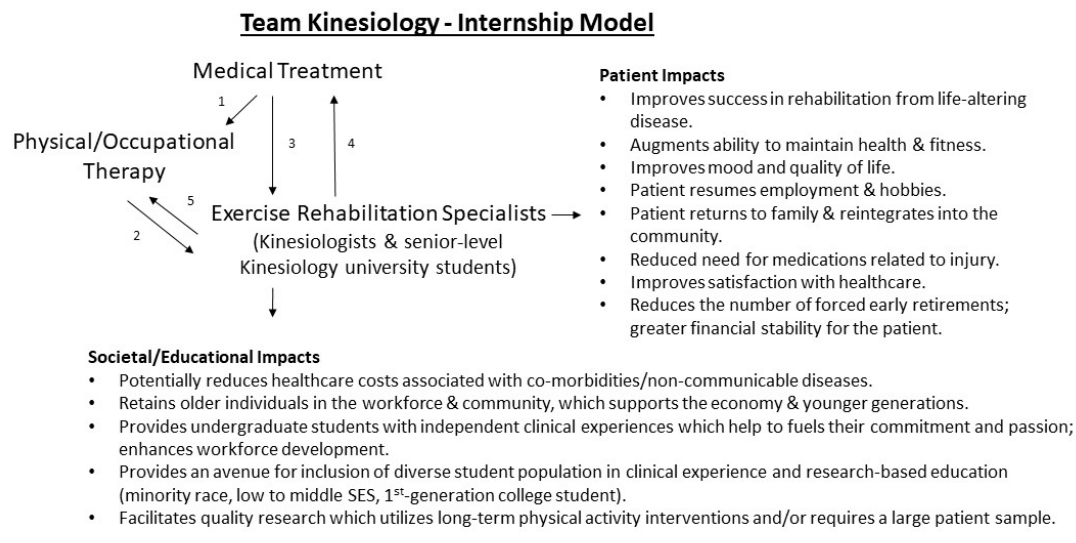
Figure 1. Proposed Team Kinesiology Model to enhance survivorship care. (1) Medical providers refer patients to therapy for the treatment of an acute diagnosis, where they receive a few visits at a time or rehabilitation for a short-term period; (2) Therapists refer patients to kinesiologists trained in working with the specific patient population (i.e., spinal cord injury, stroke, cancer patients) who help patients complete therapy homework and/or provide long-term exercise leadership to mitigate chronic conditions or dysfunction; (3) Medical providers may refer patients directly to kinesiologists for exercise programming and leadership; (4) kinesiologists refer patients back to medical providers when required, i.e., changes in health; (5) kinesiologists refer patients to therapy when required, i.e., emergence of movement-related pain. SES (socioeconomic status).